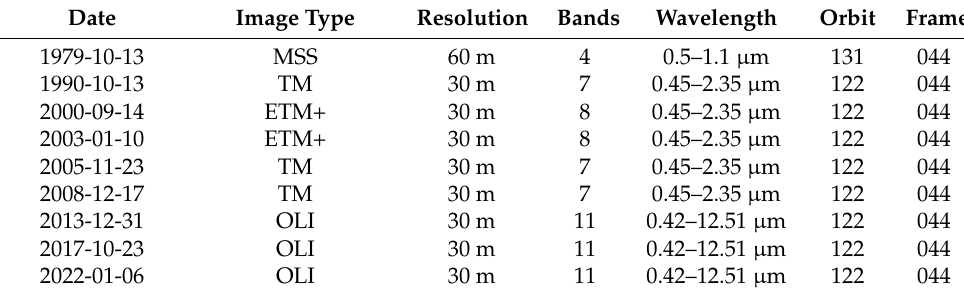
Table 1. Parameters of the used Landsat images.